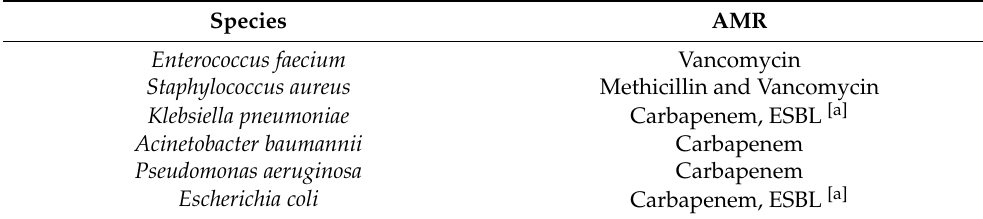
Table 7. AMR for each of the ESKAPE pathogens. Species AMR Enterococcus faecium Vancomycin Staphylococcus aureus Methicillin and Vancomycin Klebsiella pneumoniae Carbapenem, ESBL [a] Acinetobacter baumannii Carbapenem Pseudomonas aeruginosa